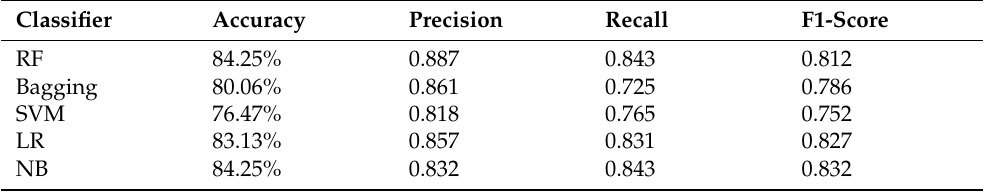
Table 26. Experiments with ML models and TF-IDF and all lexicons on Arab TextBlob sentiments.